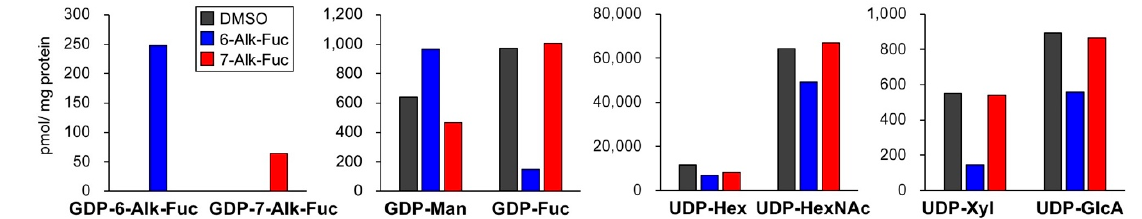
Figure 3. HEK293 cells were treated with 100 µ M peracetylated 6-Alk-Fuc, 7-Alk-Fuc, or DMSO for 24 h. The levels of GDP-Fuc analogs and other nucleotide sugars were quantified ( n = 2).